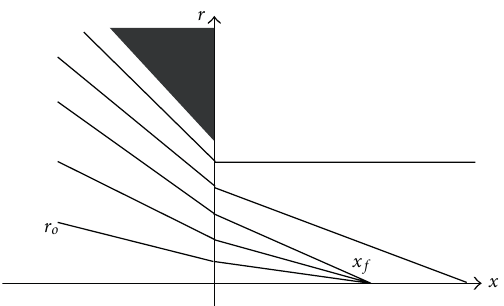
Figure 10: Diagram of particles at initial seeded radius, r o , exiting nozzle and focused at a distance, x f , from the nozzle (after [40]).